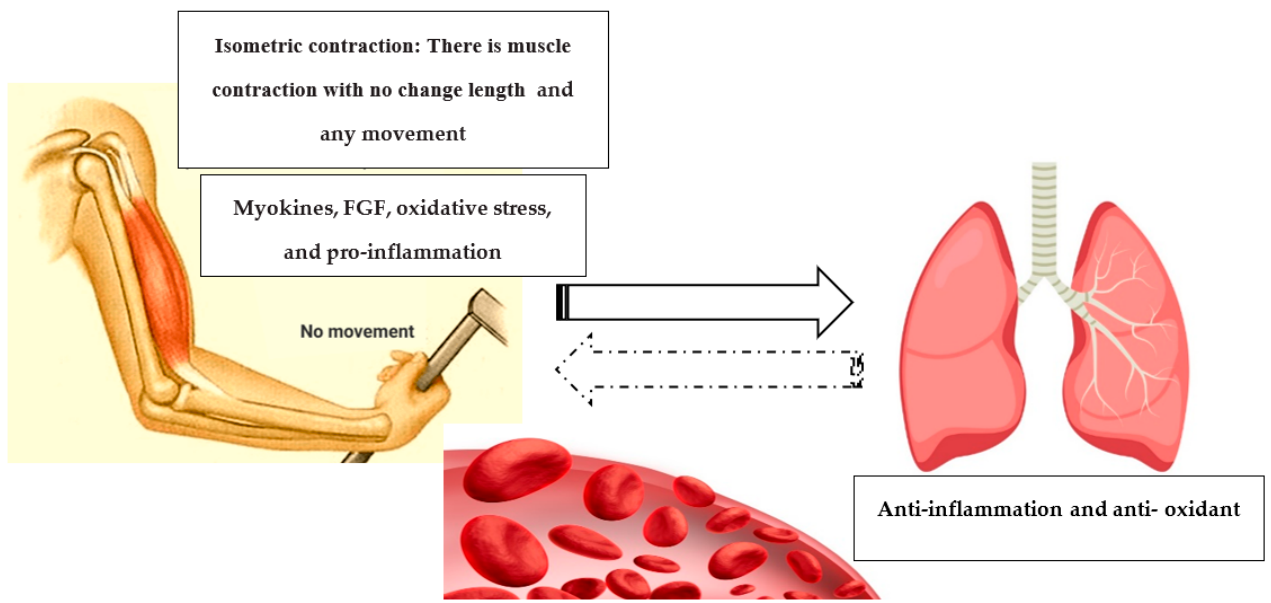
Figure 1. The relationship between isometric training system exercise and the release of myokines and FGF as anti-inflammatory effects that suppress inflammatory reactions (muscle–lung cross-talk). FGF: fibroblast growth factor.